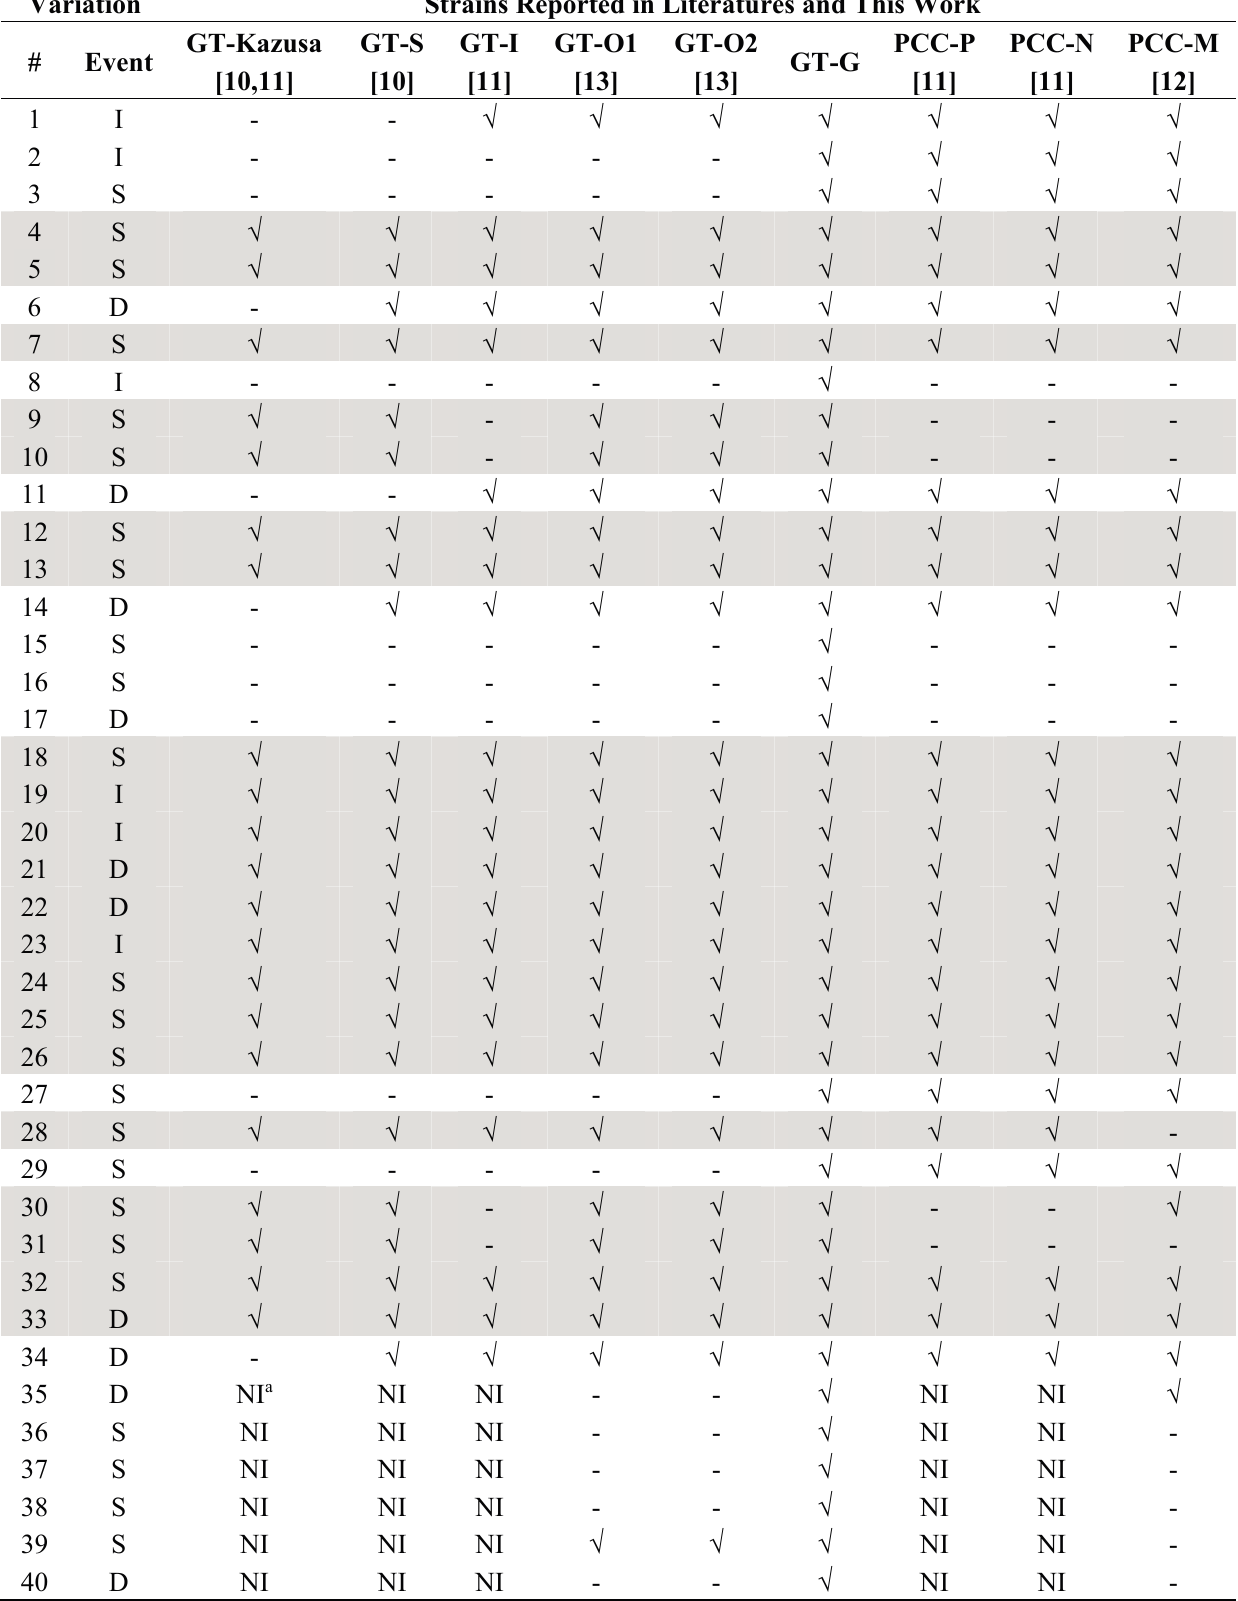
Table 2. Comparison of SNPs and indels identified in GT-G with sequences from other reported strains. The errors of database are in grey. NI a : not